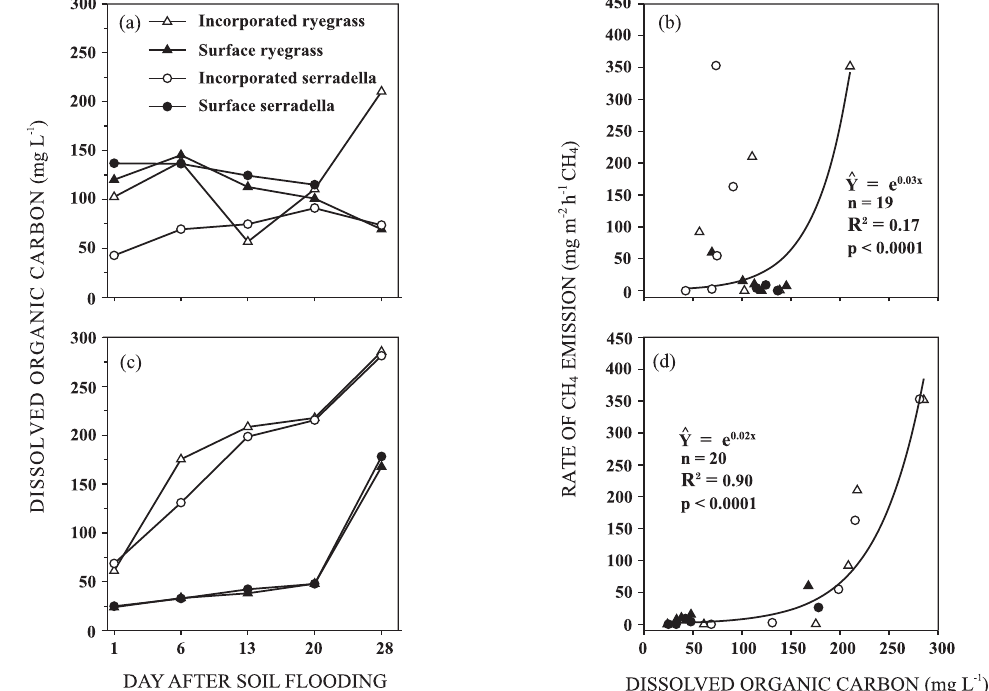
Figure 4. Concentration of dissolved organic carbon at depths of 2 and 20 cm (a and c, respectively) in a flooded Albaqualf under residue managements (incorporated or left on the soil surface) of ryegrass and serradella, and its relationship with CH emission rates (b and d, 4